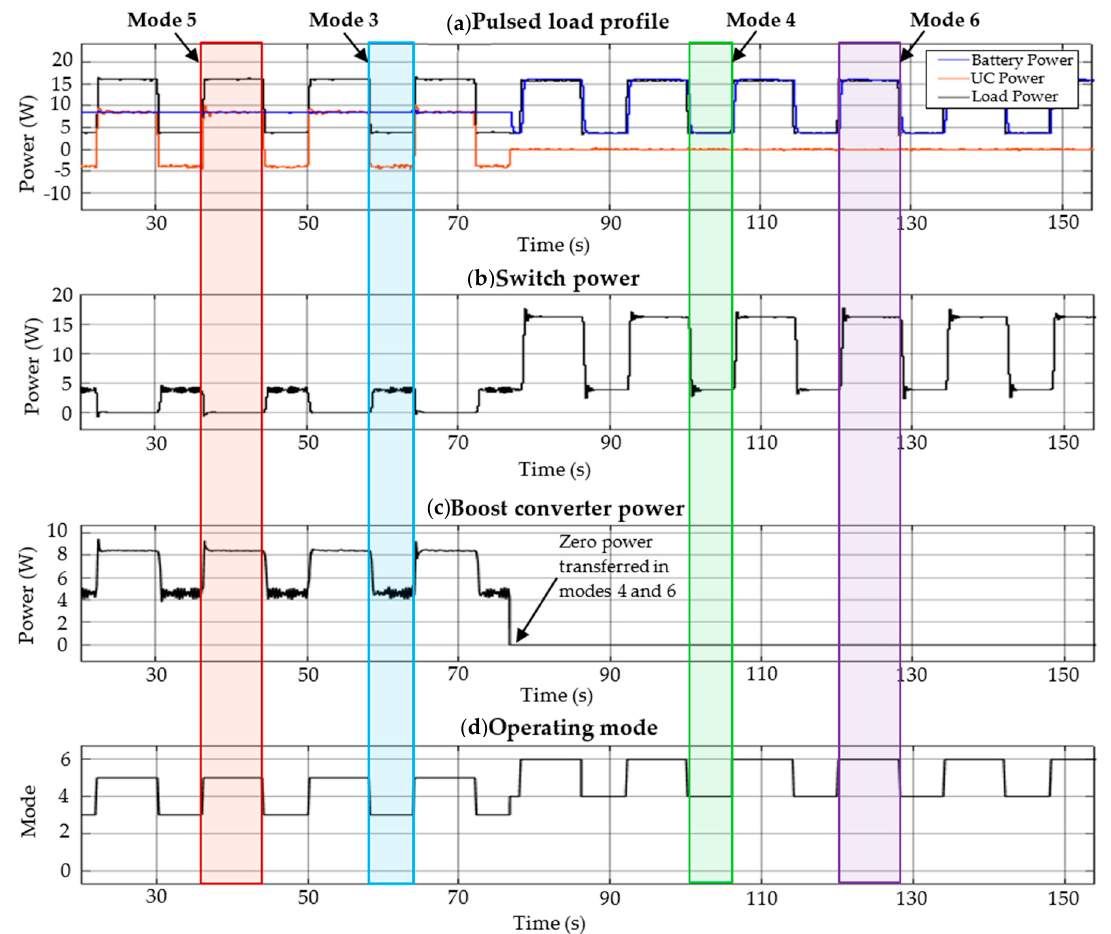
Figure 18. ( a ) Power distribution; ( b ) Power through the switch; ( c ) Power transferred through the boost converter; ( d ) Controller operating mode.